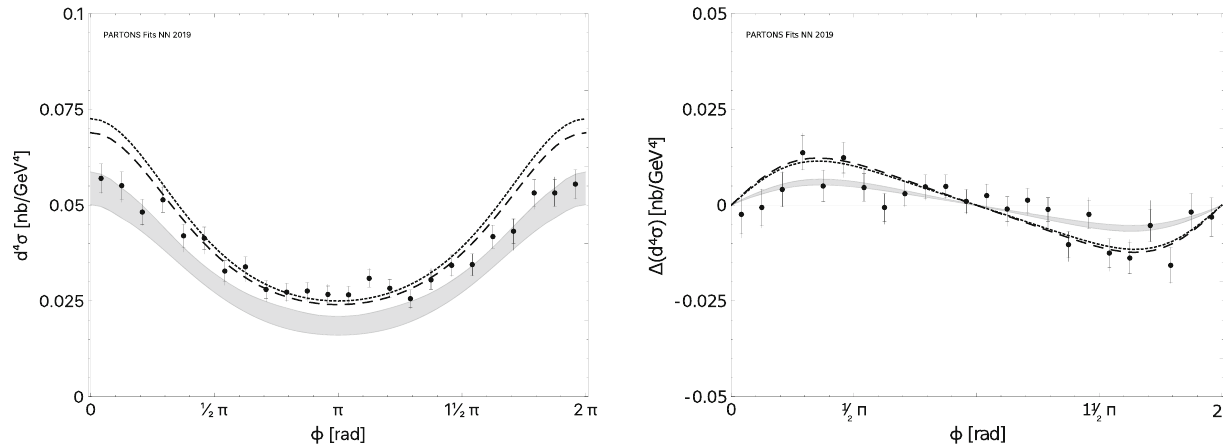
Fig. 13 Comparison between the results of this analysis, the selected GPD models and experimental data published by Hall A in Ref. [34] for d 4 σ − (left) and Δ d 4 σ − (right) at x Bj = 0 . 392, t = − 0 . 233 GeV 2 and Q 2 = 2 . 054 GeV 2 . For further description see the caption of Fig. UU LU